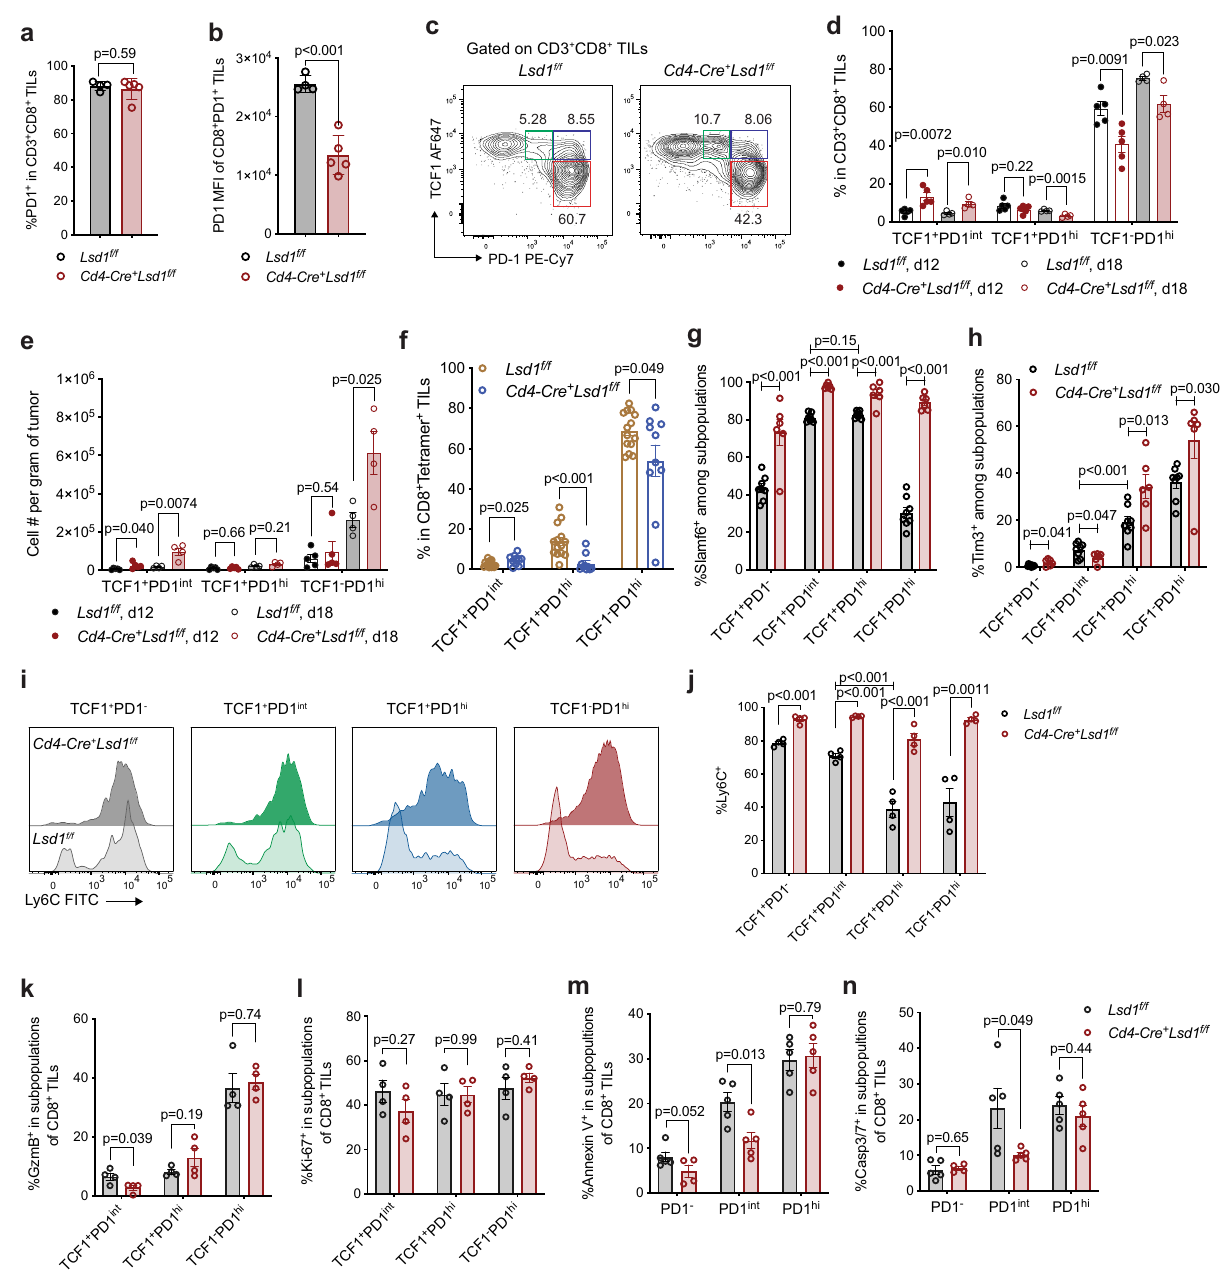
Fig. 4 LSD1 depletion preserves intratumoral TCF1 + PD-1 int progenitor exhausted CD8 + T cells. a , b Frequencies ( a ) and PD-1 MFI ( b ) of CD8 + PD-1